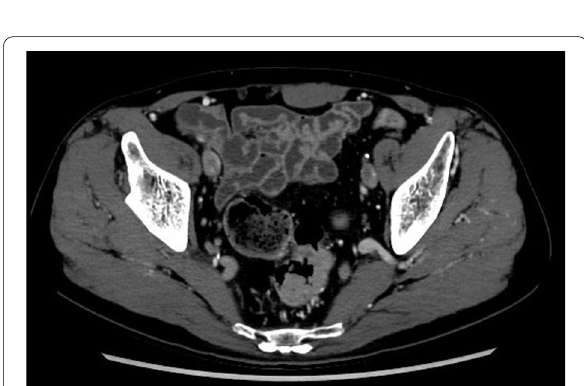
Fig. 2 Abdominal contrast-enhanced computed tomography (CT) revealed a thickened rectal wall, but no obvious distant metastasis (white arrow)